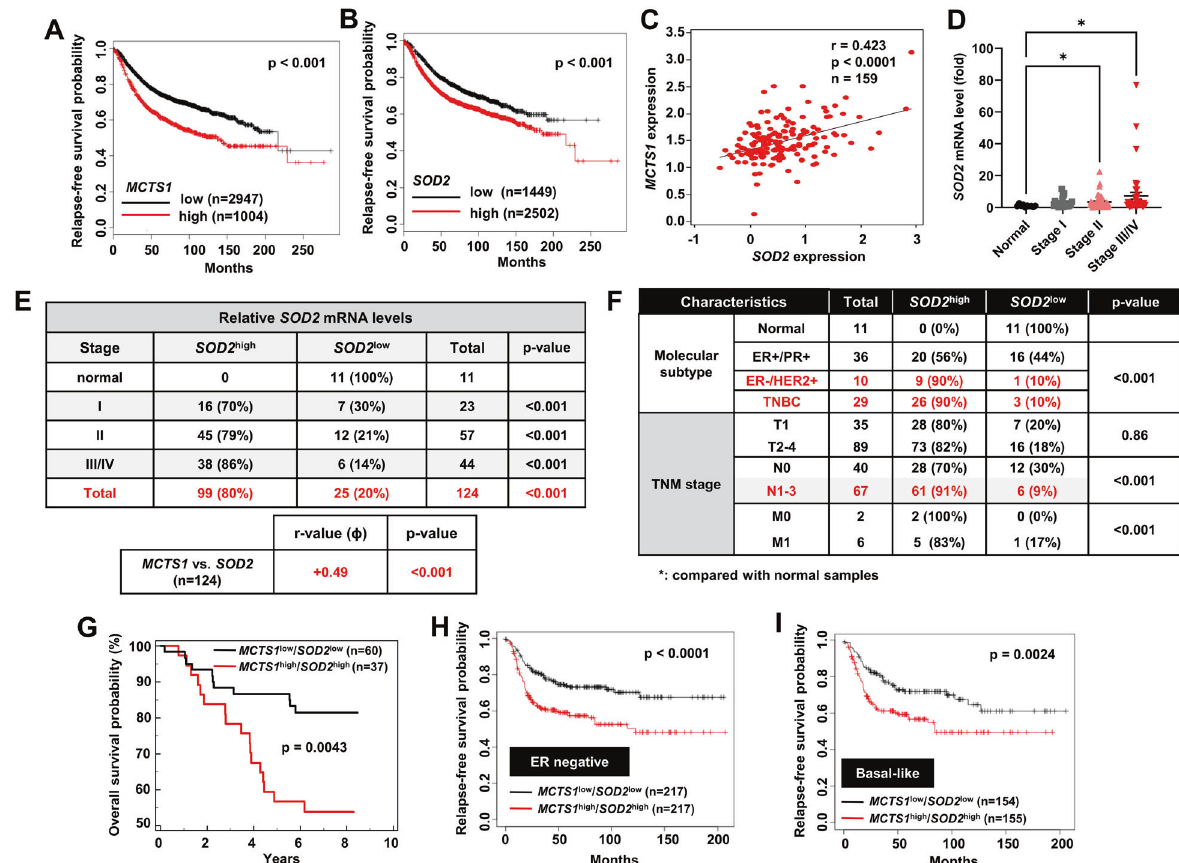
Fig. 1 SOD2 high / MCTS1 high expression is a new poor prognostic marker in invasive breast carcinoma. A , B The relapse-free survival (RFS) of breast cancer patients classi fi ed by low ( n = 2947) and high ( n = 1004) MCTS1 expression ( A ) or by low ( n = 1449) and high ( n = 2502) SOD2 expression ( B ) was evaluated using Kaplan – Meier (KM) Plotter analysis. C The correlation of MCTS1 and SOD2 gene expression in breast cancer patients ( n = 159) was analyzed using the Pawitan dataset in the Oncomine cancer pro fi ling database. D – F SOD2 expression was analyzed in TissueScan cDNA arrays with normal breast tissue ( n = 11) and breast tumor biopsies ( n = 124) across distinctive tumor stages ( D , E ), molecular subtypes and TNM classi fi cations ( F ). The SOD2 mRNA levels in tumor samples were normalized to internal ACTB ( β -actin) mRNA levels and then compared with the levels in normal breast samples. Data are presented as the mean ±s.e.m. G KM Plotter was used to estimate the survival of patients with MCTS1 high / SOD2 high ( n = 37) expression compared with that of those with MCTS1 low / SOD2 low ( n = 60) expression using the Pawitan dataset in the Oncomine database. H , I RFS was estimated for ER-negative ( n = 434) ( H ) and basal-like ( n = 309) ( I ) breast cancer patients with MCTS1 high / SOD2 high or MCTS1 low / SOD2 low expression using KM Plotter. Statistical analysis was performed using the log-rank Mantel – Cox test ( A , B